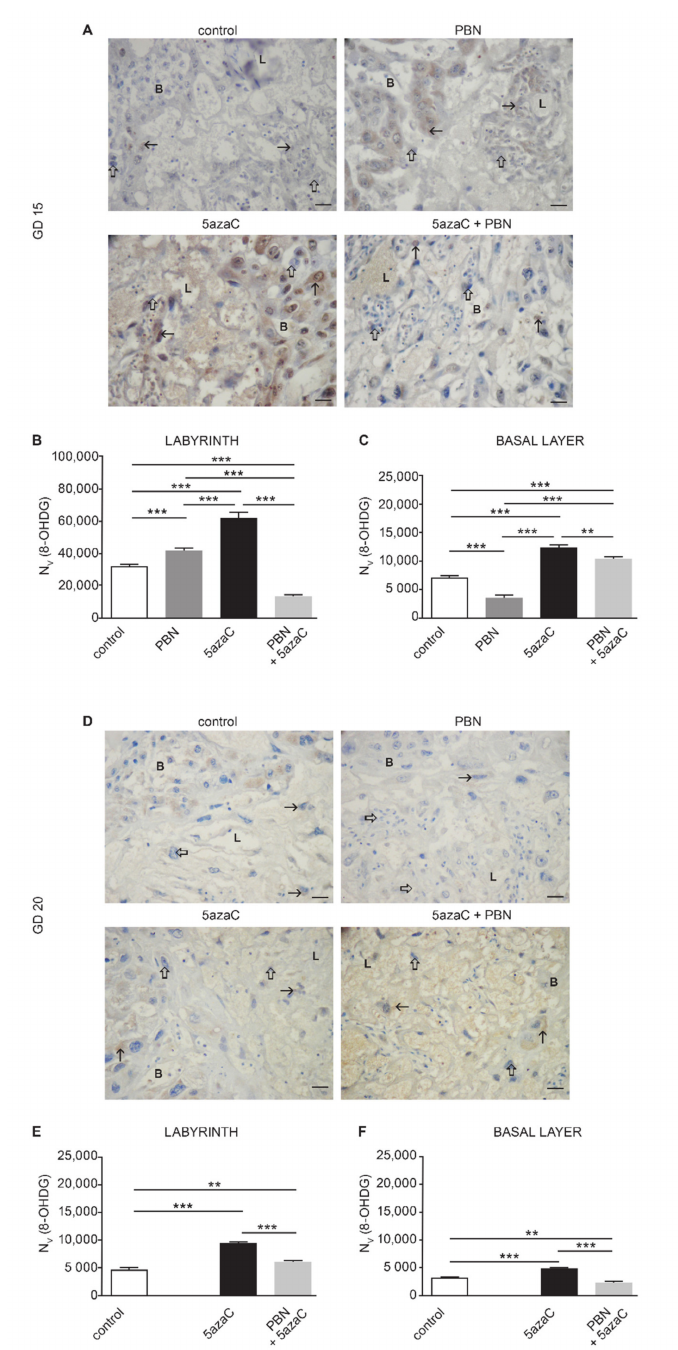
2.5.1. 8-Hydroxy-2 (cid:48) deoxyguanosine (8-OHdG) Oxidative stress was first investigated in single-placenta cells using an oxoguanosine (8-OHdG) marker in placental samples of all three groups of treated animals and in controls (Figure 4).